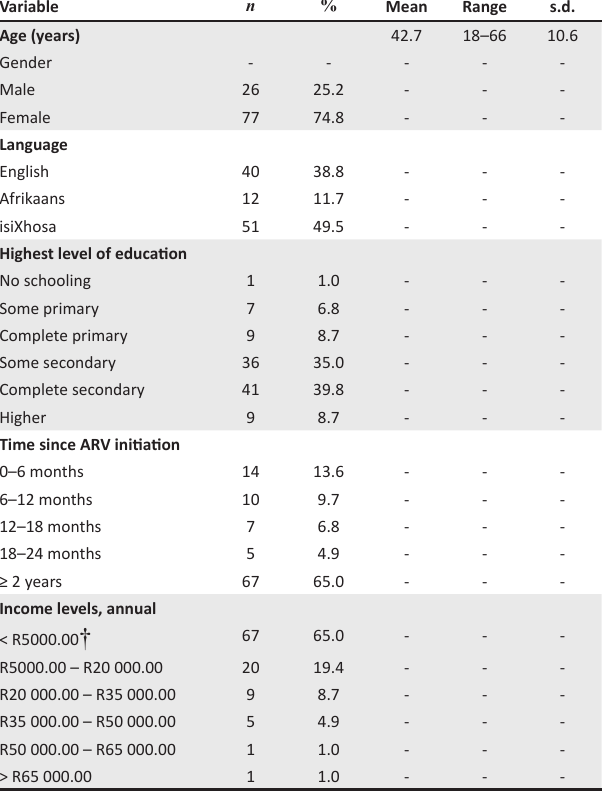
TABLE 1 : Participant